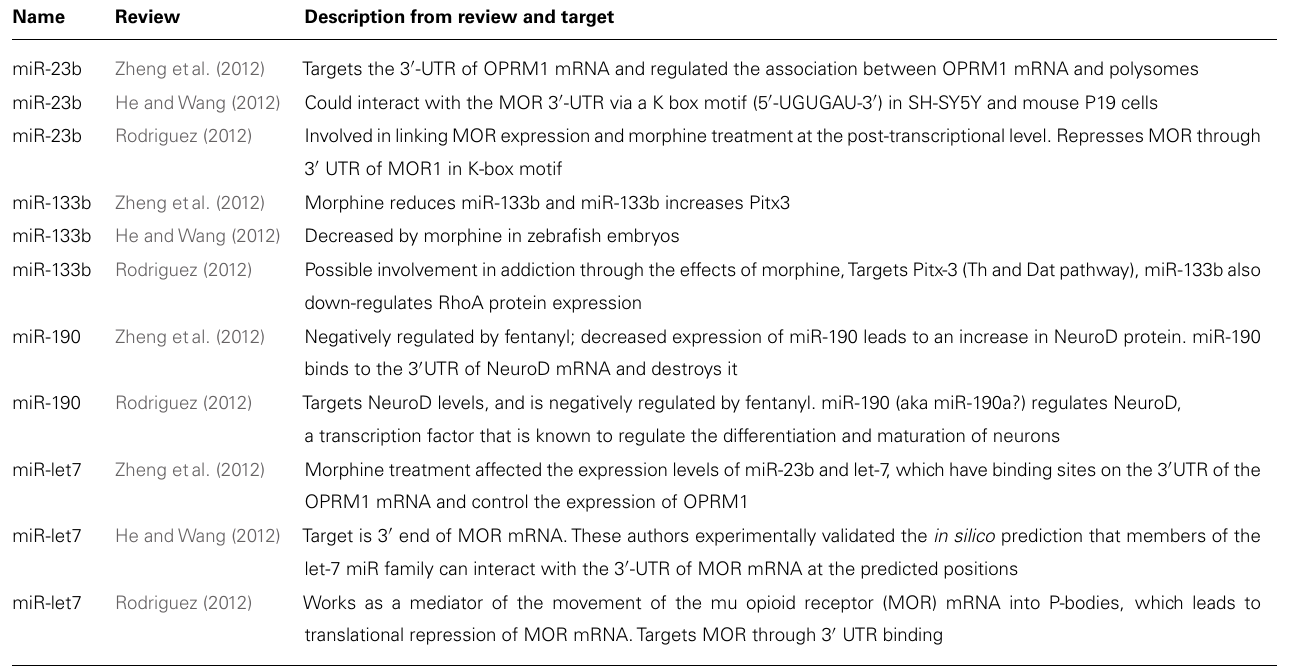
Table 1 | MicroRNAs and morphine: function and conservation − MicroRNA names, functions, and targets from the “MicroRNAs and Morphine” chapter of the Frontiers SpecialTopic “Non-Coding RNA andAddiction.”